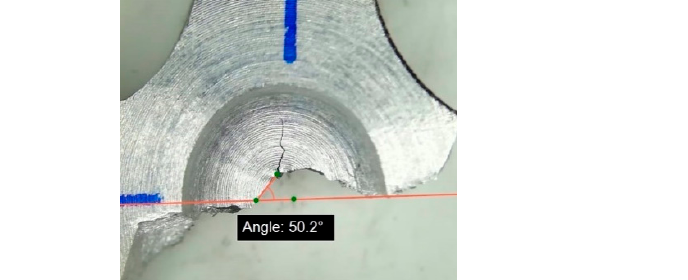
Figure 26. Cruciform C-T specimen failed after tension/tension (out-of-phase) biaxial UFT at VHCF [24].